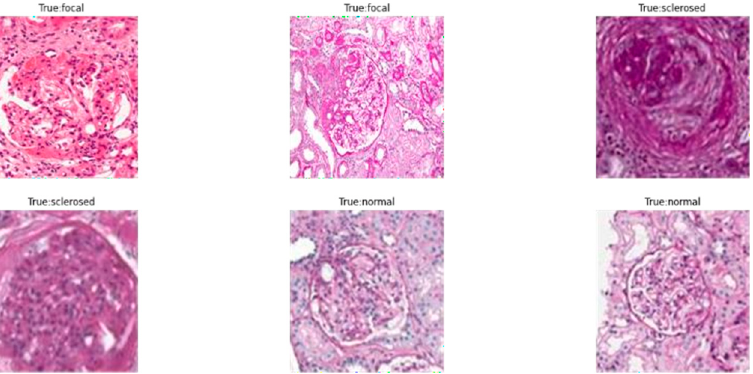
Figure 2. Sample Images of the validation set for the focal-segmental, sclerosed and normal glomeruli.